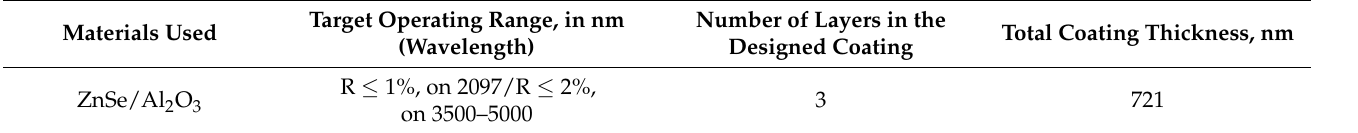
Table 2. Characteristics of the calculated coating.